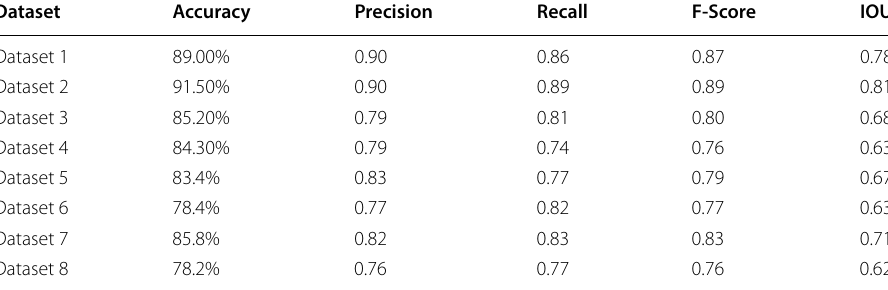
Table 1 Building extraction performance results